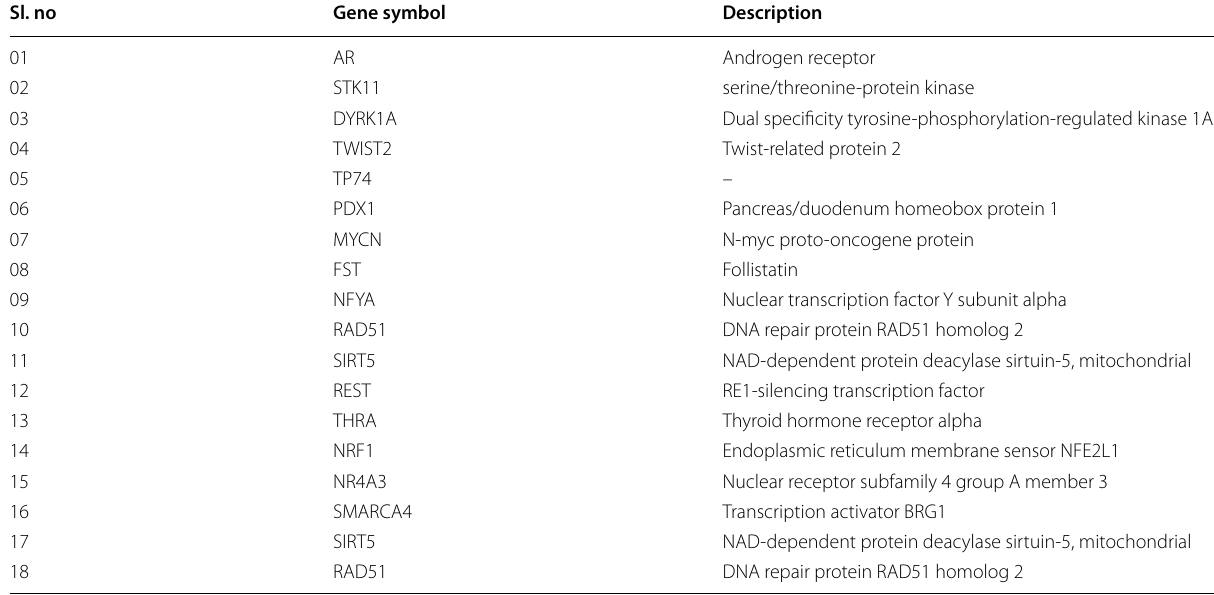
Table 1 List of genes in the backbone network Sl.